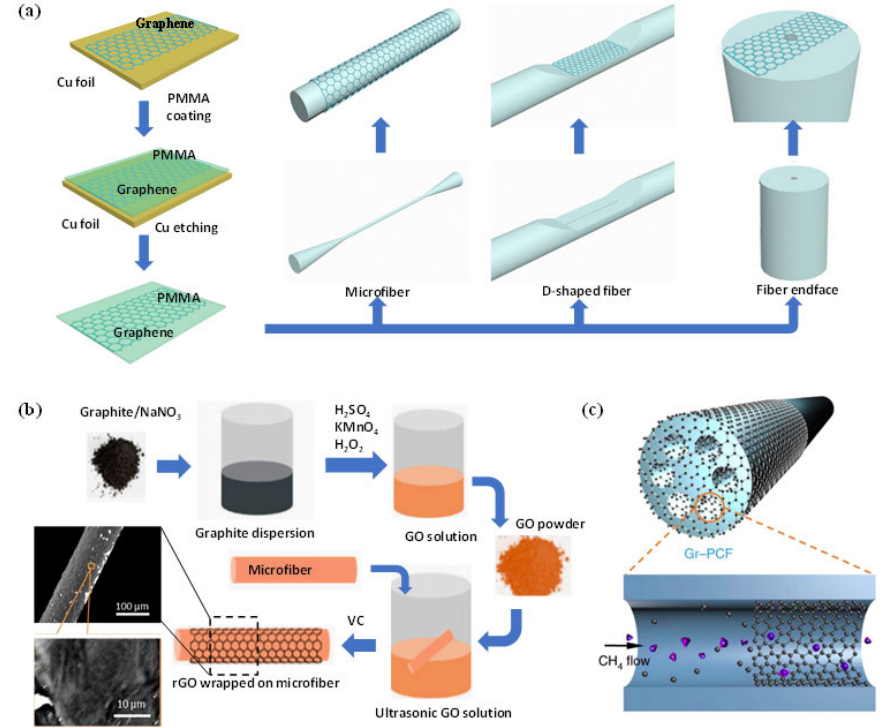
Fig. 3 Fabrication of graphene-based fiber structures: (a) schematic diagram of wet transfer combining graphene with the microfiber, D-shaped fiber, and fiber endface [43], (b) flow of depositing method based on GO reduction [20], and (c) schematics of graphene-PCF grown by the CVD method